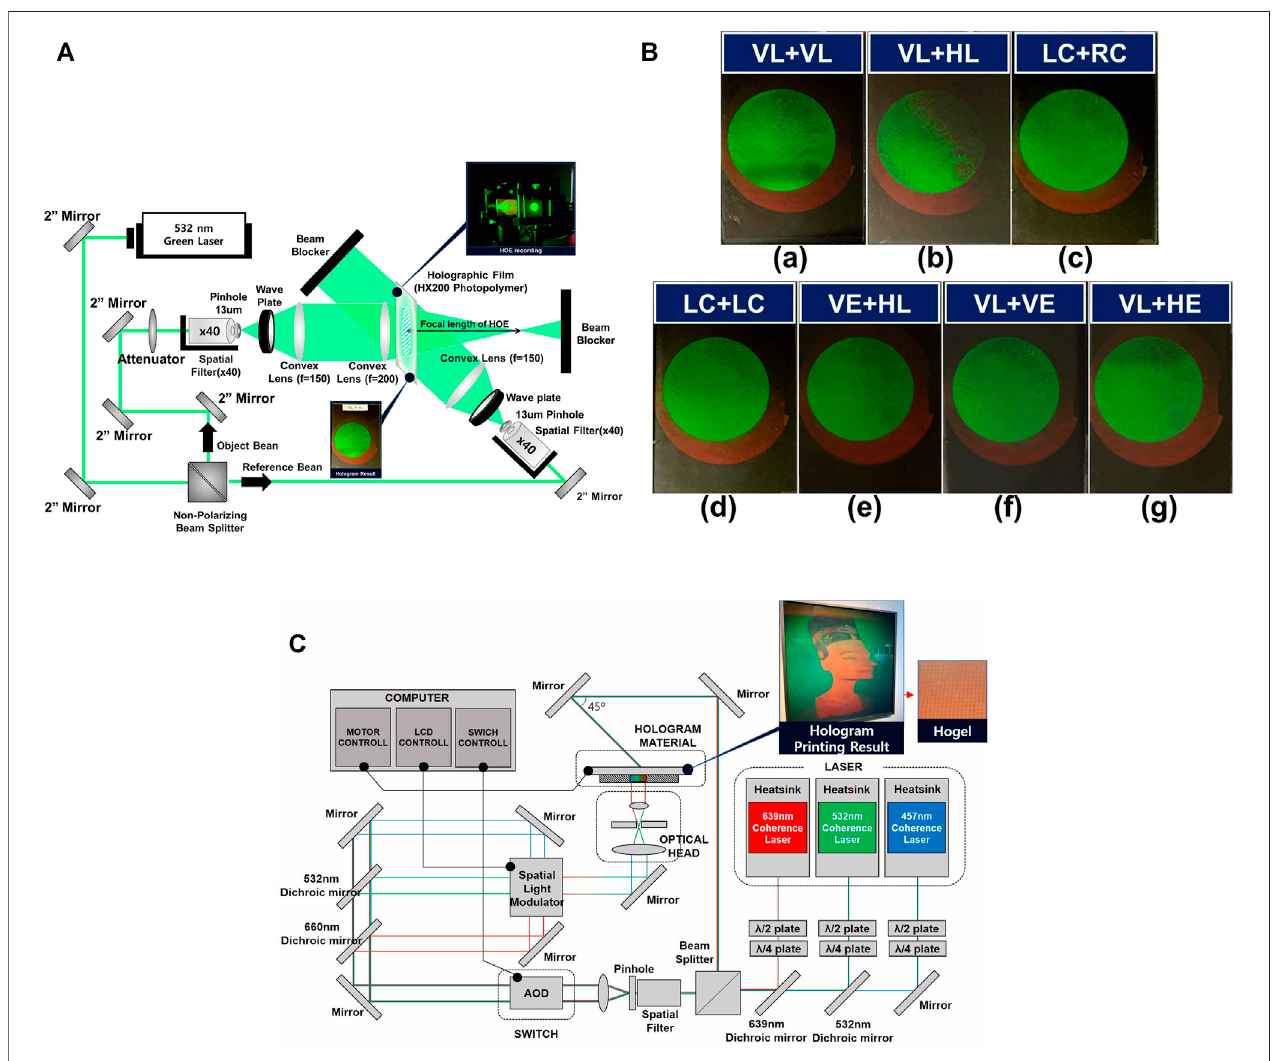
FIGURE 2 | Fabrication of holographic optical elements with focal length of 200 mm using different polarization. (A) Schematic of optical system (B) HOE results from polarization matching.